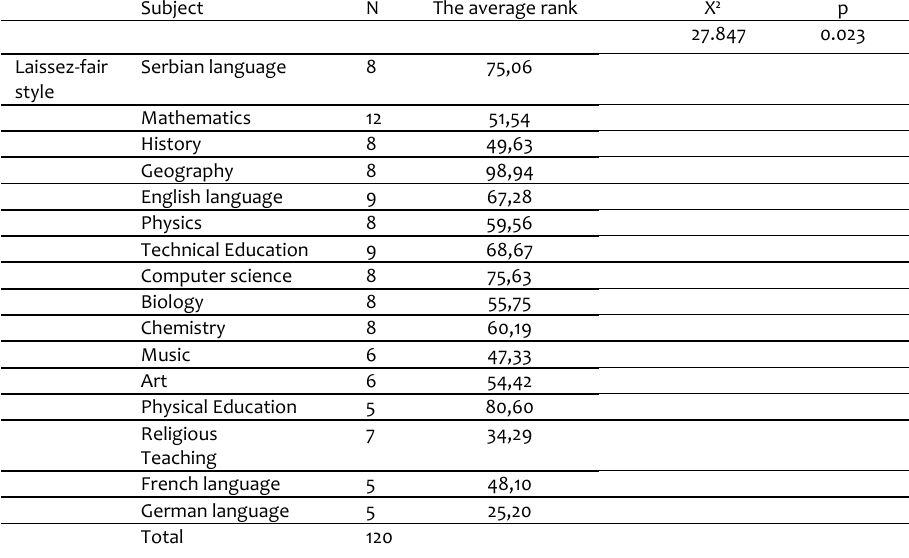
Table 3. Differences in teachers' assessments of indifferent work